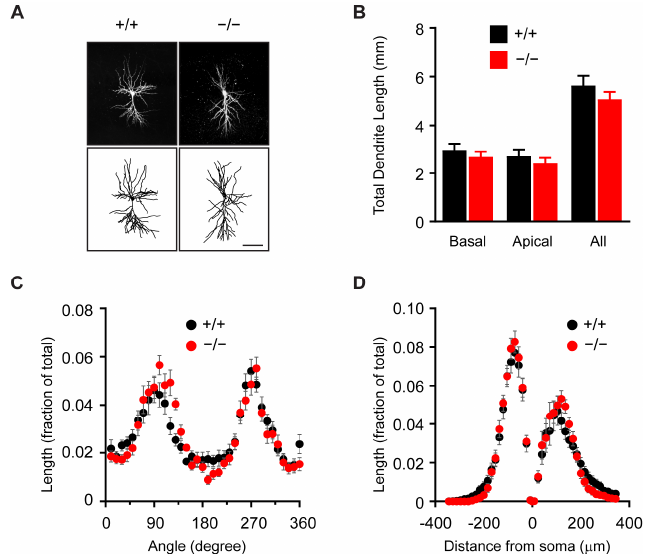
Figure 1. Astroglial Cx43 does not alter neuronal morphology. ( A ) Representative images of a CA1 pyramidal neuron dialyzed with sulforhodamine B via a patch pipette in a wild-type (+/+, left) and a Cx43 − / − ( − / − , right) hippocampus. The maximum z-projection of the confocal images are shown on the top, and reconstruction of the same neurons are shown at the bottom. ( B ) The plots show the average of the total length of the basal, apical, and all dendrites. ( C ) The fraction of the total dendrites at discrete angles around the cell soma in polar histograms, and ( D ) the fraction of total dendrites intersecting in concentric circles away from the cell soma as shown by Sholl analysis. These analyses show no significant differences in the dendritic organization between pyramidal neurons in +/+ and − / − mice. Mean ± SEM; n = 20 +/+ and 19 − / − cells; and scale bar: 100 µ m in ( A